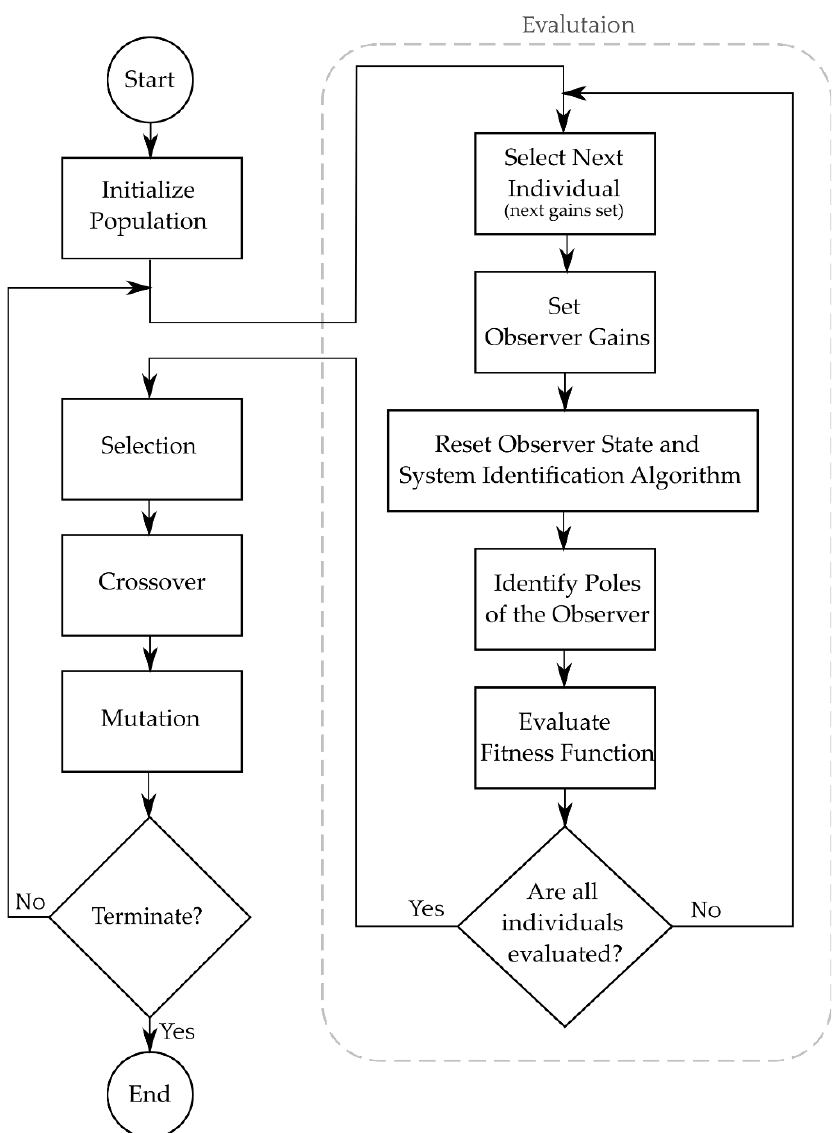
Figure 1. Gains selection algorithm.